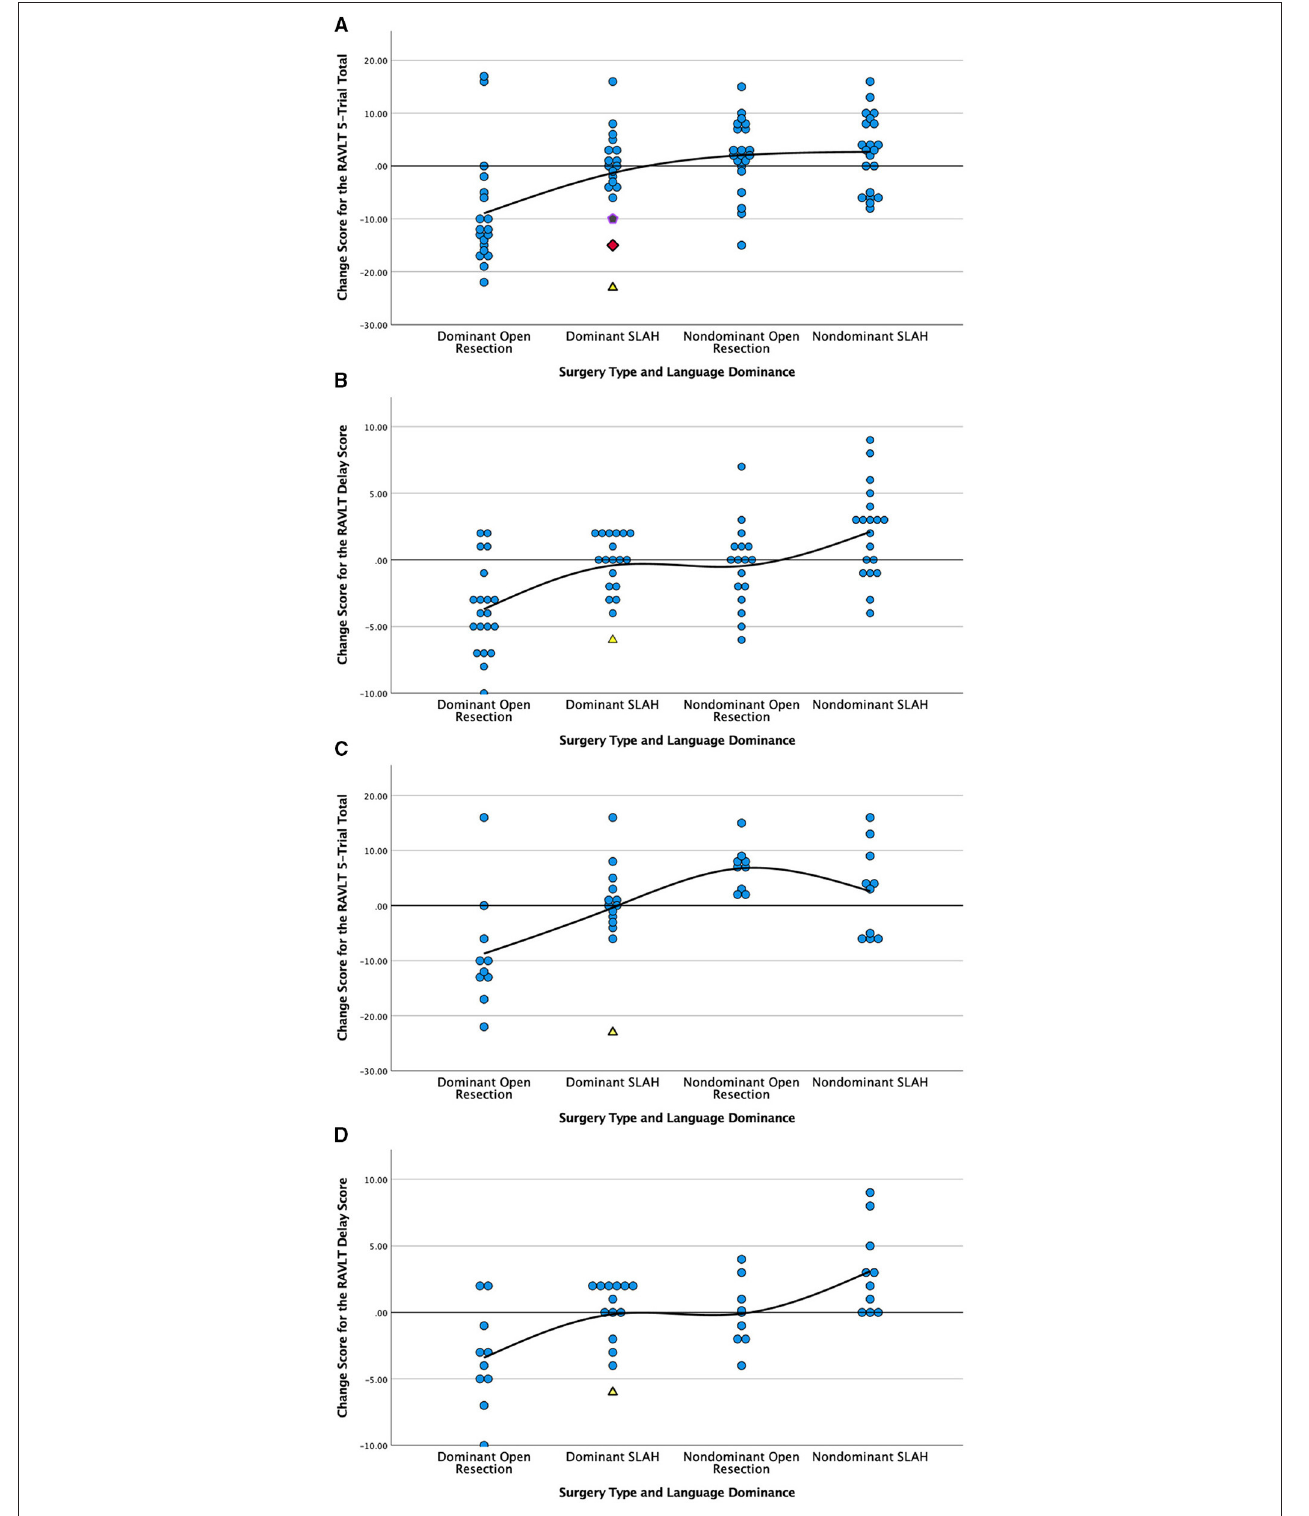
FIGURE 2 | Comparison of post-surgical change in verbal memory by surgery type and language dominance for all patients (A,B) and only those with MTS (C,D) . Change is presented in raw scores as scatter plots grouped by type of surgery and laterality of seizures. Verbal Learning, RAVLT 5-Trial Total Score; Verbal